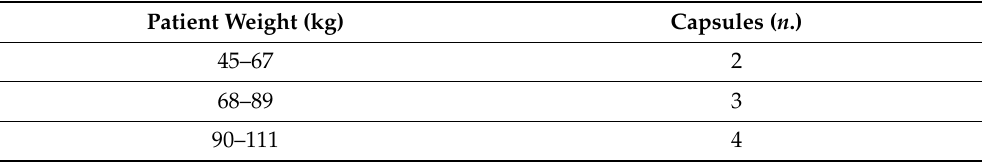
Table 1. Dosage of LAGS capsules. Each capsule contains 450 mg of BIOintestil ® , composed of 90